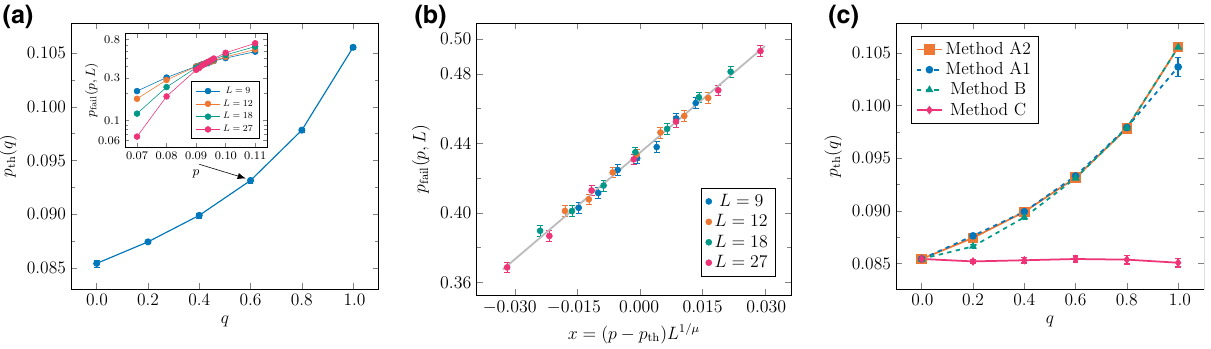
FIG. 8. (a) A plot of the error threshold p th as a function of q for the ensemble of HCT codes produced using method A1. The inset shows a plot of the logical error rate p fail as a function of the phase-flip error rate p for q = 0.6. (b) The rescaled data for the inset in (a), using finite-size scaling analysis to estimate the threshold. The fitting parameters for the collapse are p th = 0.0932 ( 1 ) and μ = 1.42 ( 8 ) and the gray line shows a quadratic fit. (c) A comparison of the behavior of the error threshold as a function of q for different methods of constructing HCT